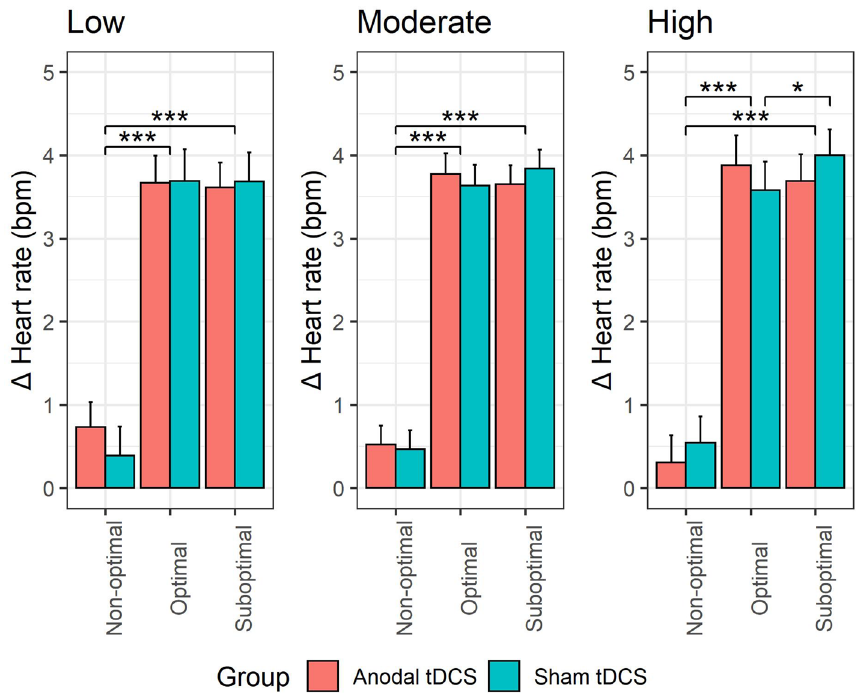
Figure 6. Role of level of self-critical rumination in tDCS effects on cardiovascular reactivity to choice outcomes. Error bars reflect the standard error. * p < 0.05; *** p <